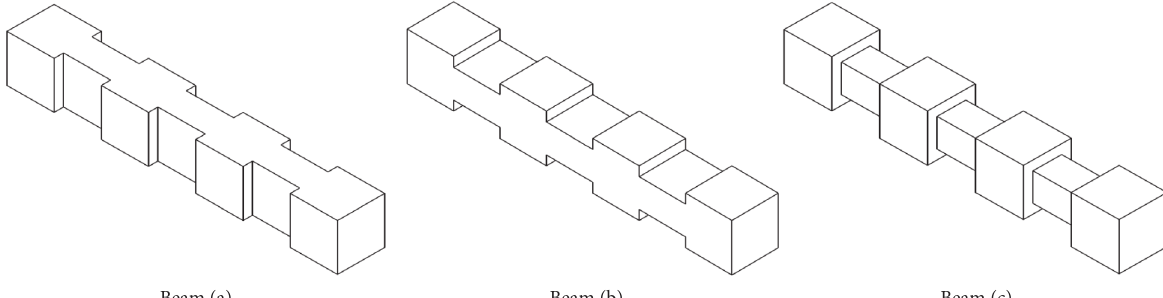
Figure 1: Three representative cases of stepped beams.